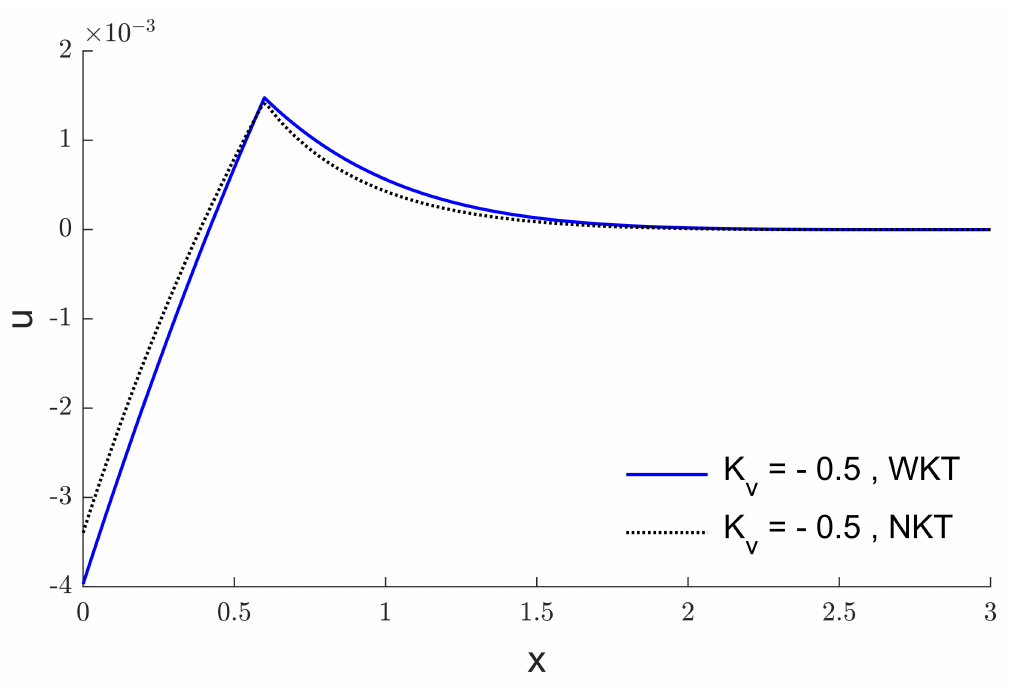
Figure 8. The displacement variation with and without Kirchhoff transform when K v = − 0.5.